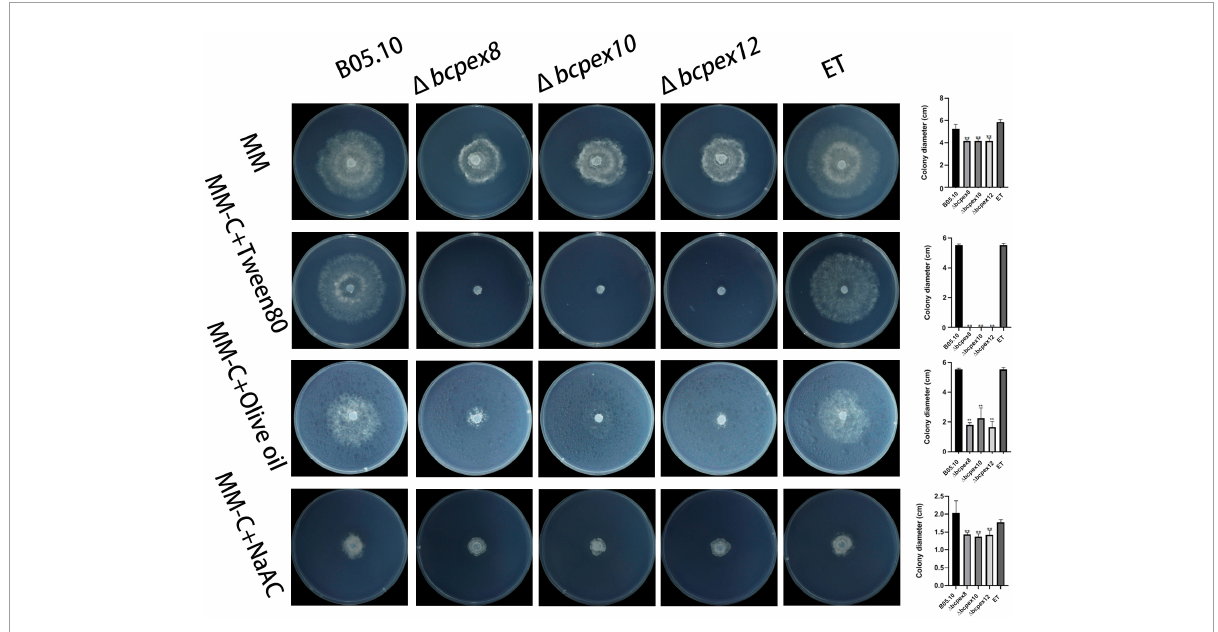
FIGURE7 Lipid utilization assays of (cid:49) bcpex8 , (cid:49) bcpex10 , and (cid:49) bcpex12 mutants and WT and ET strains. The strains were cultured on MM plate supplemented with 1% tween 80, 1% olive oil, 50 mM sodium acetate, 10 g/L maltase, or 10 g/L sucrose and were observed at 3 dpi (** p < 0.01).